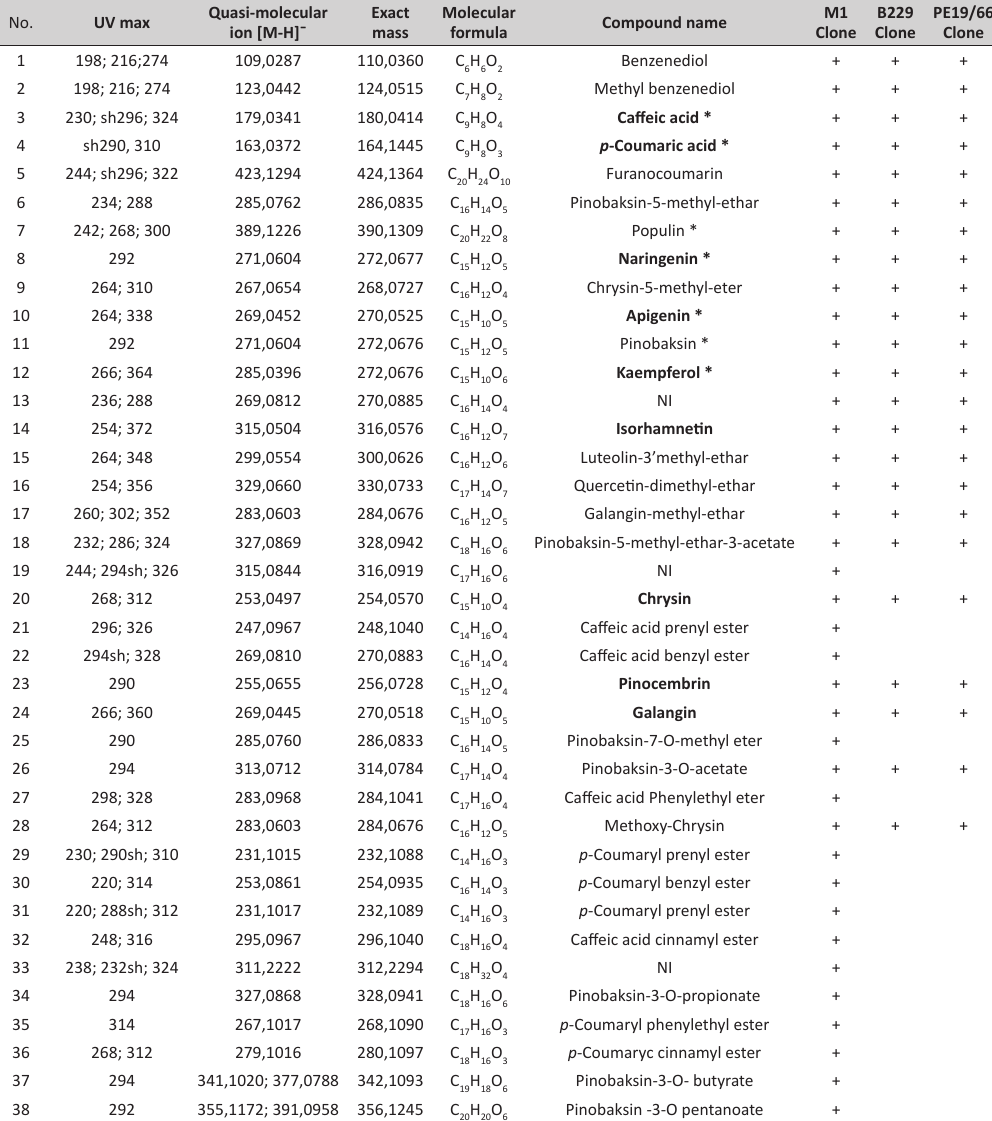
TAbLe 1. A list of identified compounds within surface resins of three poplar clones. Abbreviation NI means Not Identified. Compounds marked with * were previously reported in Trudić et al. [20]. Bolded compounds are compounds identified by internal